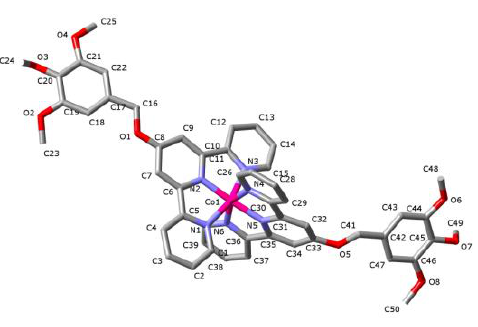
Figure 9. Temperature-dependent magnetic susceptibility measurements for [Co( L3 )